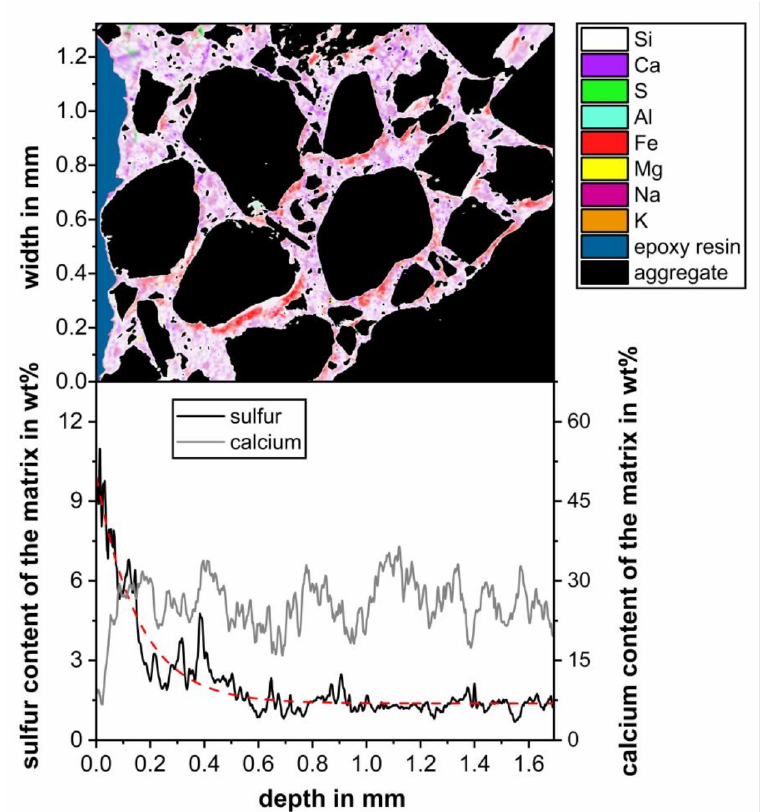
Figure 15. EDX map of a concrete sample with CEM I 42.5 N-SR3 (w/c = 0.50) stored for 182 d at 5 ◦ C in Na 2 SO 4 solution with 6000 mg SO 42 − /L and corresponding depth